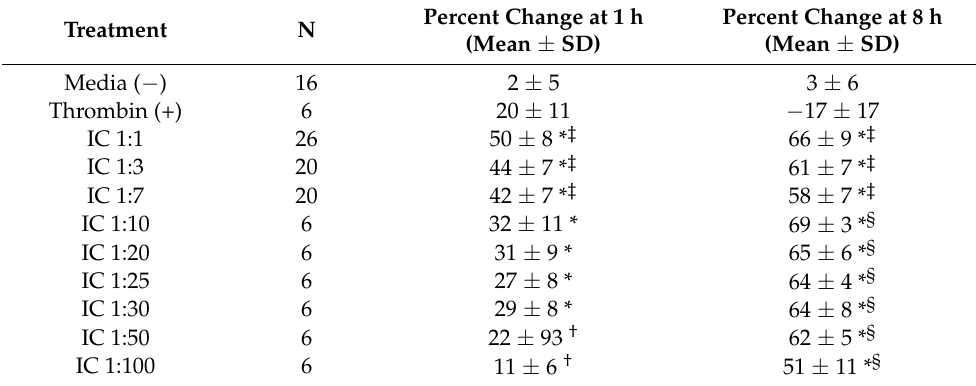
Table 2. Percent change in TEER of HPAEC over 8 h after exposure to various concentrations of IC as compared to media and thrombin. Data shown in mean ±